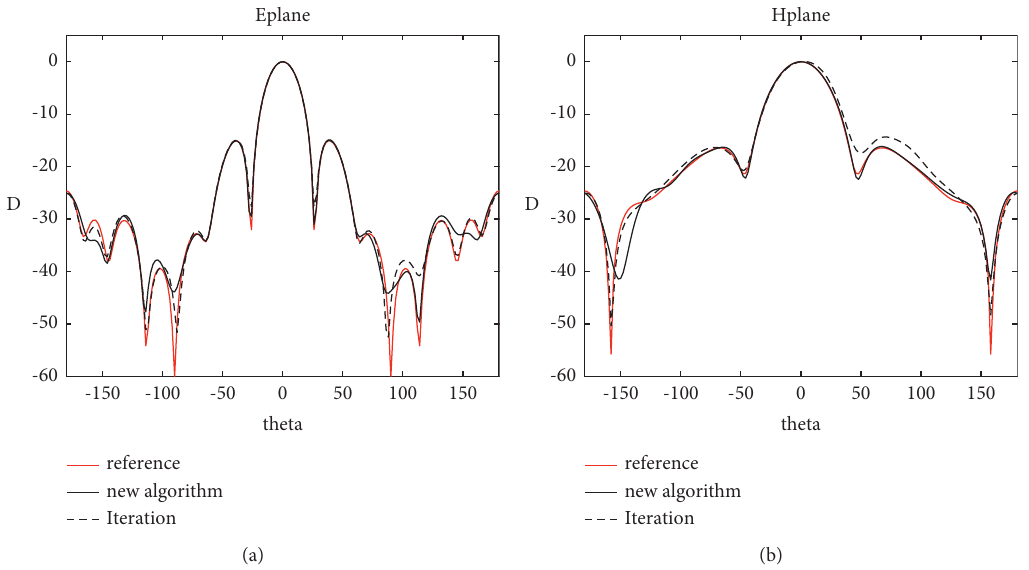
Figure 17: The extrapolated radiation pattern utilizing the algorithm proposed in [6, 8, 35]. (a) E-plane. (b)